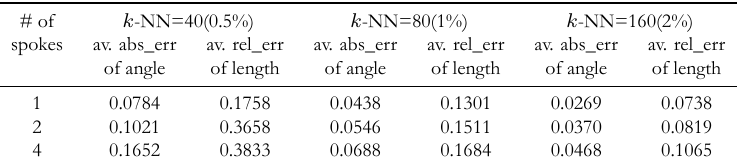
Table 2: Results of ℓ 1 MCDA on Student t -based radial data